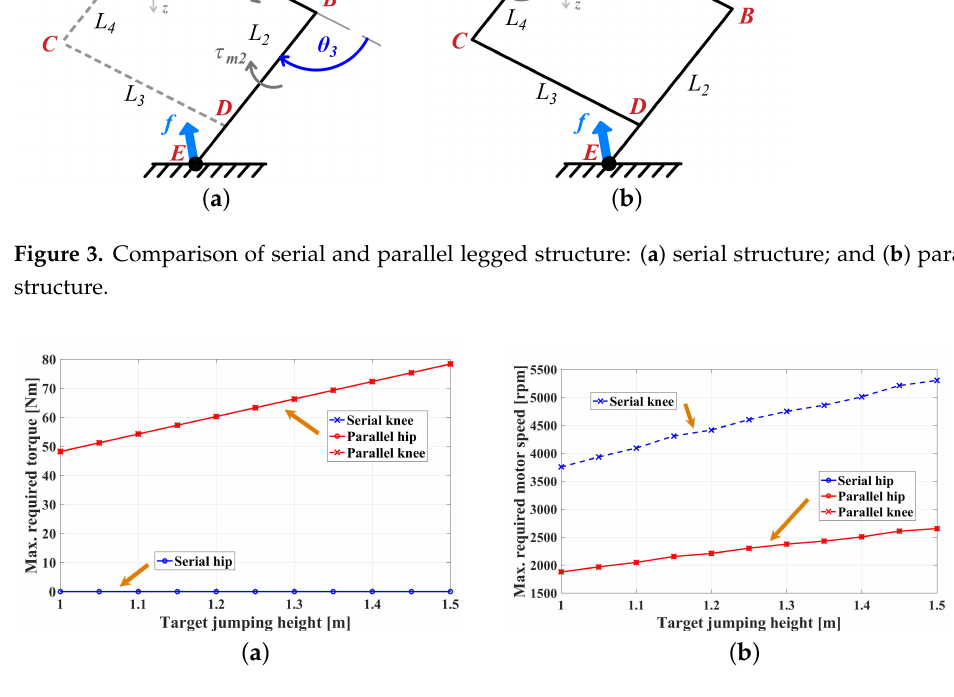
Figure 4. Maximum requirements of ( a ) torque and ( b ) motor speed in vertical jumping to different target heights (5.5 kg robot), with serial and parallel structures respectively: ( a ) the value of serial hip is always at 0, while the other three curves (serial knee, parallel hip, and parallel knee) are overlapped; and ( b ) the value of serial knee is much higher than the other three overlapped curves (serial hip, parallel hip, and parallel knee). Thus, the requirements of actuator with parallel structure are more balanced than those of serial.